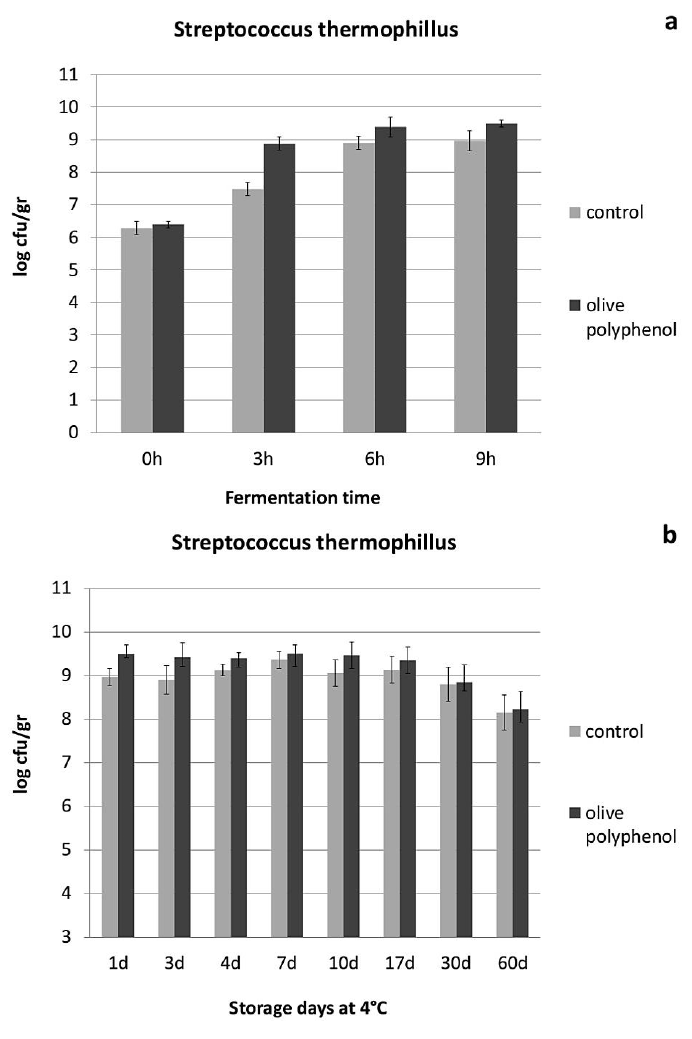
Figure 2. Population of Streptococcus thermophillus during fermentation ( a ) and refrigerated storage ( b ) of yogurts with or without addition of 1250 ppm of olive polyphenols.